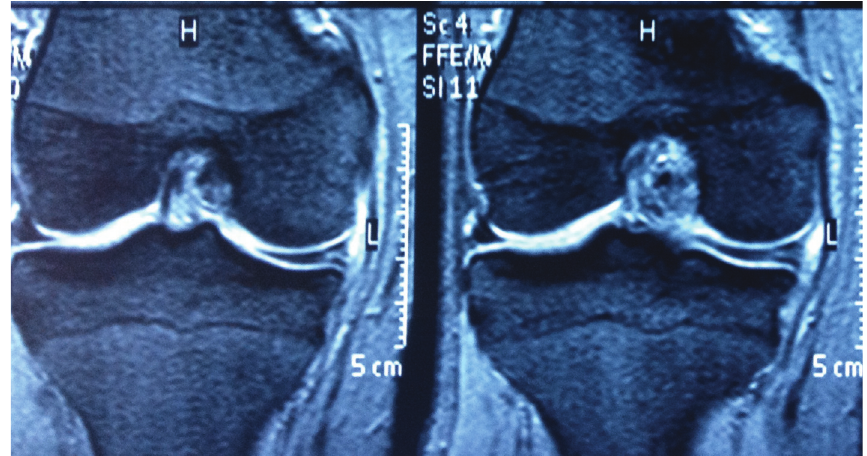
Figure 1. Preoperative coronal magnetic resonance (MR) image of the right knee. Small horizontal tear is seen on the peripheral meniscus. Larger part of meniscus is intact on the central part.